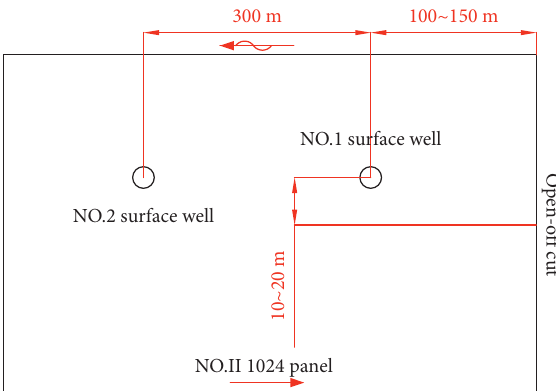
Figure 8: Schematic diagram of surface well’s